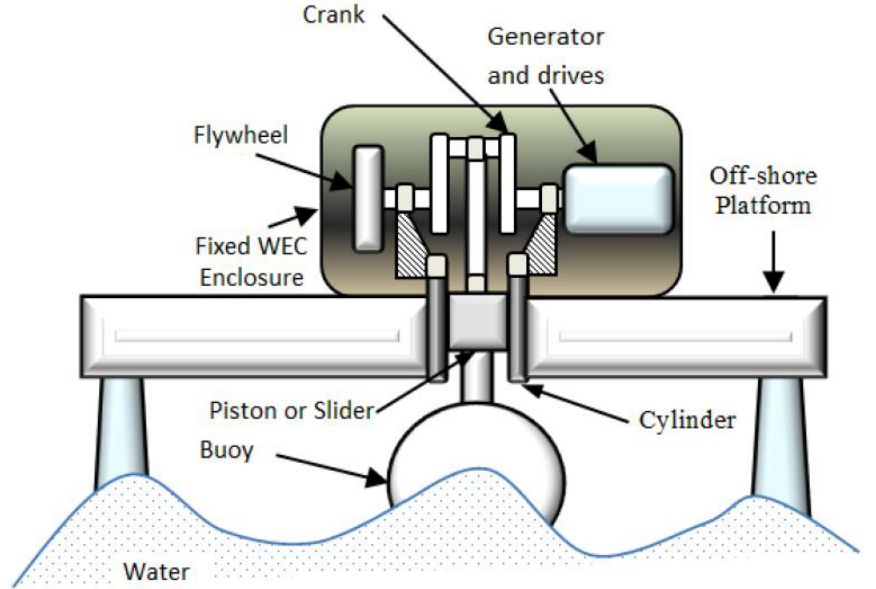
Figure 19. Crank slider mechanism schematic [37,47] .